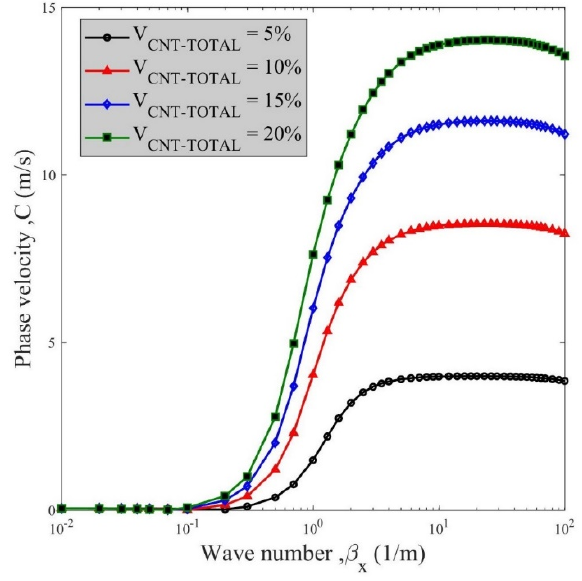
Figure 3. Phase velocity vs. wave number for various volume fractions of CNTs.